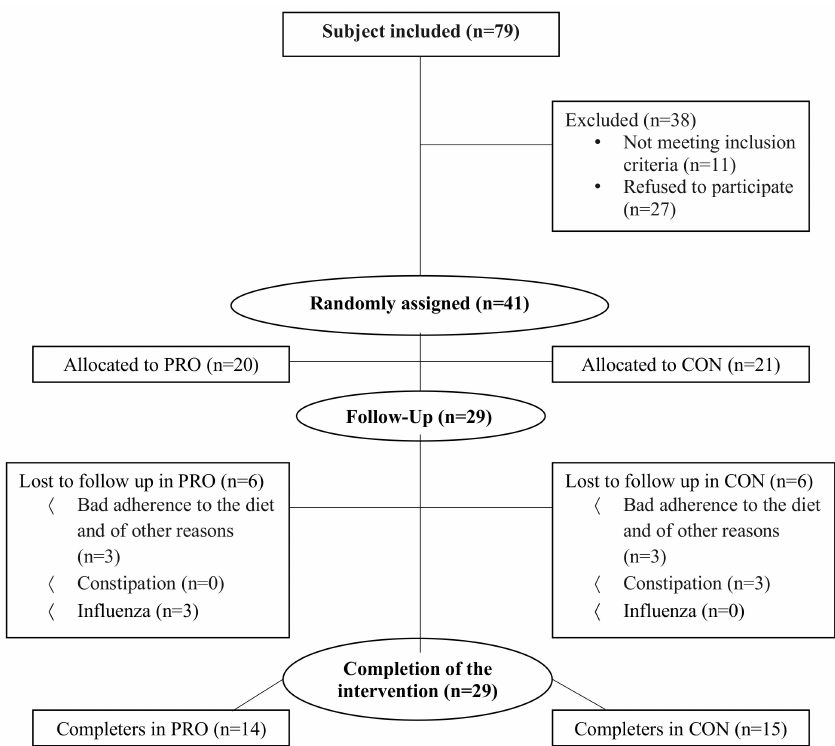
Figure 2. Flowchart of recruitment and completion of the trial. PRO: protein group, CON: Control group. n: number of subjects, FM: Fat mass, FFM: Fat free mass.